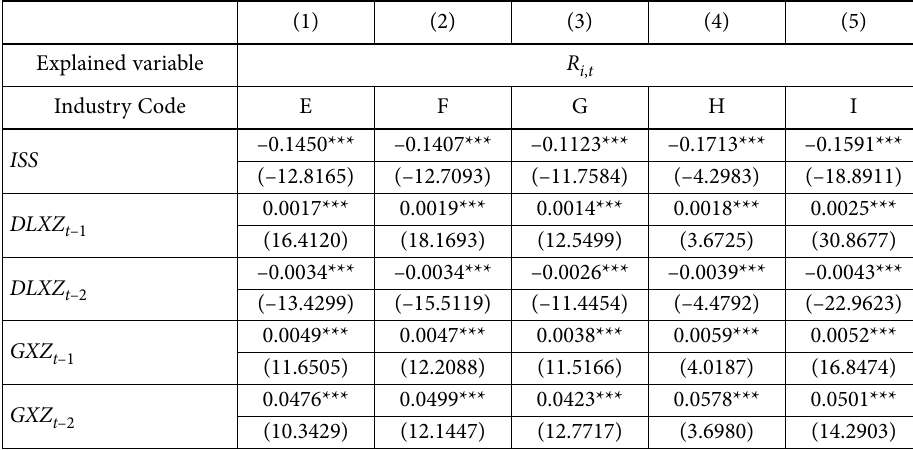
Table 9. Influence of information infection on stock market